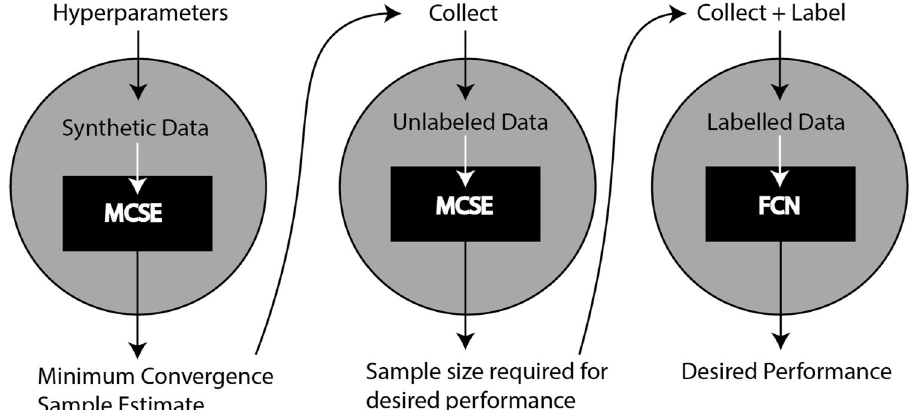
Fig. 5 Data collection pipeline with minimum convergence sample estimation. Stage 1 of the pipeline is to use hyper-parameters to estimate a minimum convergence sample. Stage 2 is to collect the number of samples estimated by the MCSE, and use that to determine the sample size required for a desired performance via MCSE and Eq. (3). Stage 3 is to collect the number of samples required, label those samples and train on the FCN to achieve the desired performance.